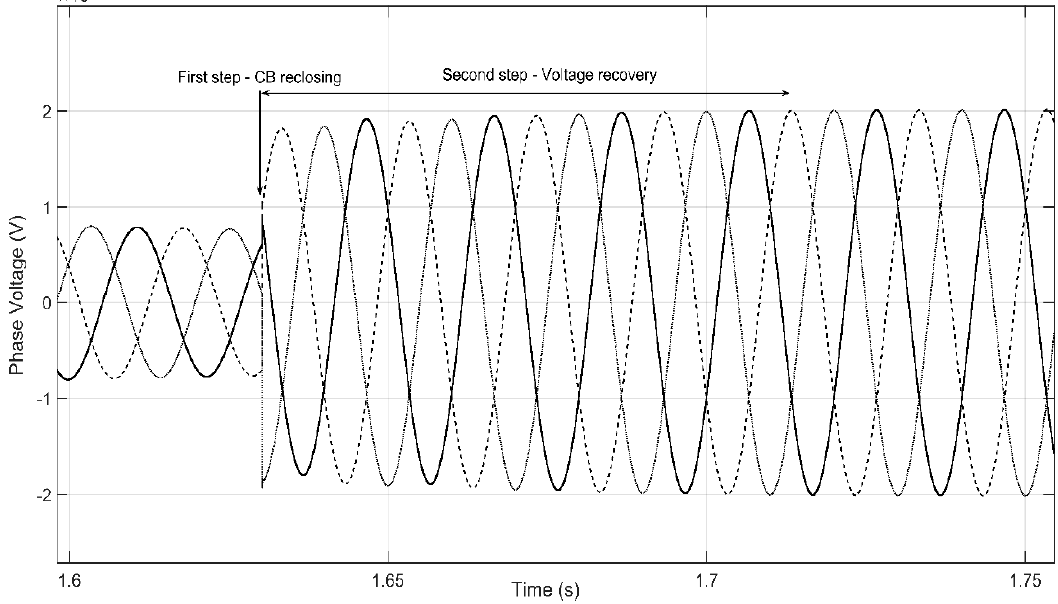
Figure 11. Two-step voltage sag recovery.